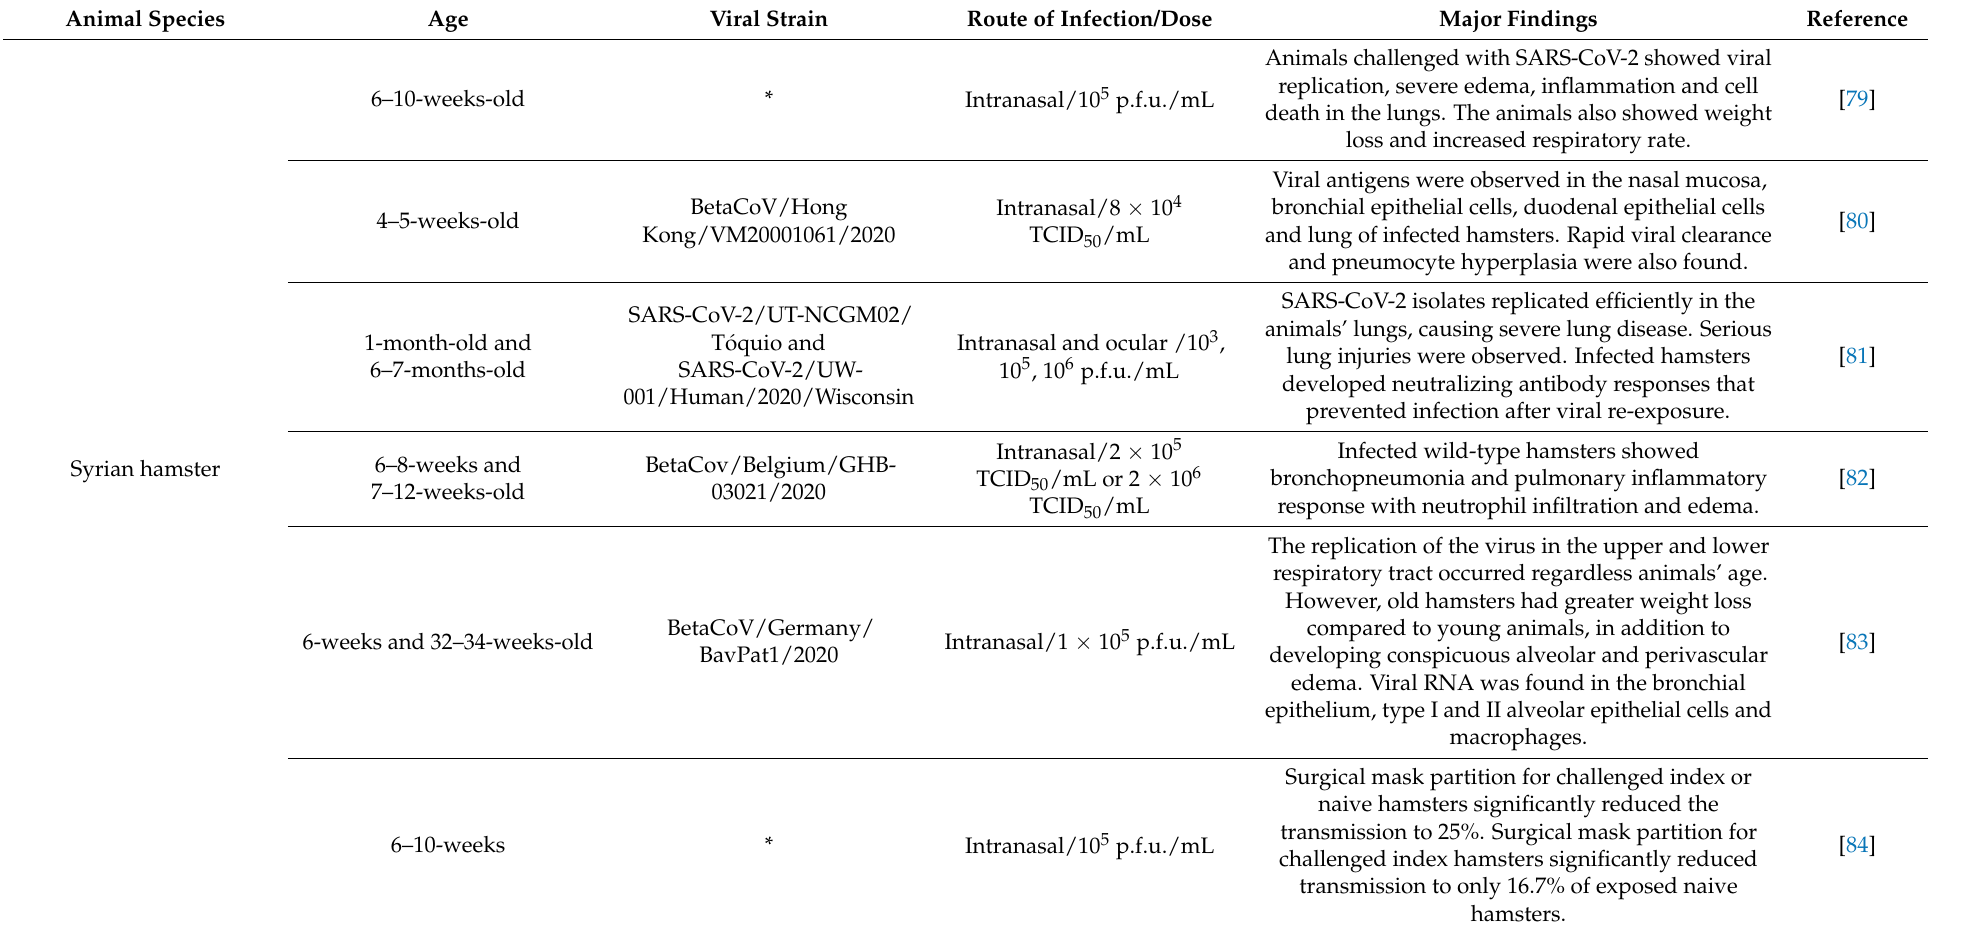
Table 3. Non-murine models for SARS-CoV-2 studies (except non-human primates). Animal